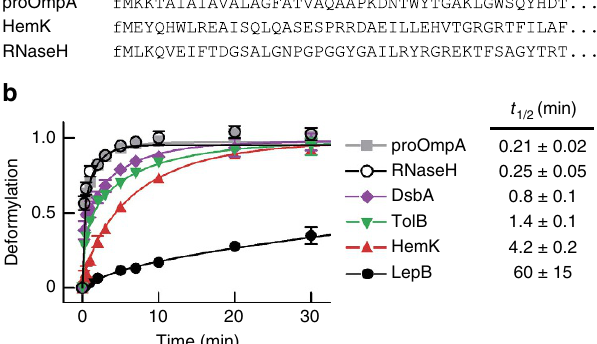
Figure 1 | Deformylation of various RNCs with nascent peptides of 75 amino acids. ( a ) N-terminal sequences of RNCs. SRP-specific signal (TolB, DsbA) or signal-anchor (LepB) sequences are highlighted and the N-terminal formyl group is denoted by f. Positions where proline residues were inserted are underlined in the LepB sequence. ( b ) Time courses and t 1/2 values of RNC deformylation. Assays were performed with 50nM RNC carrying f[ 35 S]Met at the N terminus and 10nM PDF, and were analysed by TLC (Methods section; Supplementary Fig. 1). The extent of deformylation is normalized by the maximum extent of deformylation of the respective RNC after 60min set to 1; in the case of LepB, the maximum deformylation was estimated by fitting the time course measured up to 150min. For un-normalized time courses, Supplementary Fig. 2. Evaluation of the time courses (left panel), as described in Methods section, yielded t 1/2 values (right panel). Error margins represent s.e.m. ( n ¼ 2). NATURE COMMUNICATIONS|8:15562|DOI: